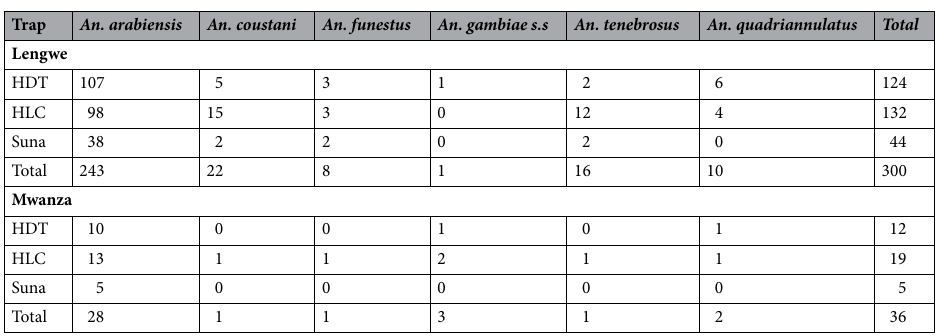
Table 1. Number of mosquitoes caught per trap per village which were identified to